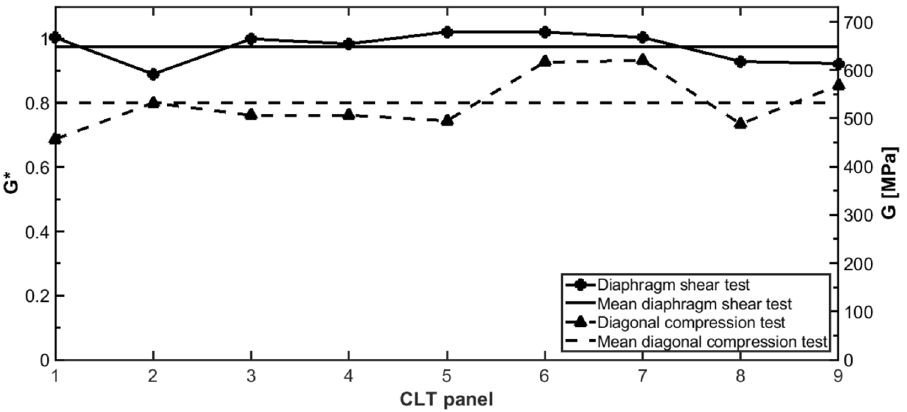
Fig. 7 Individual CLT panels tested in the diaphragm shear test and the diagonal compres- sion